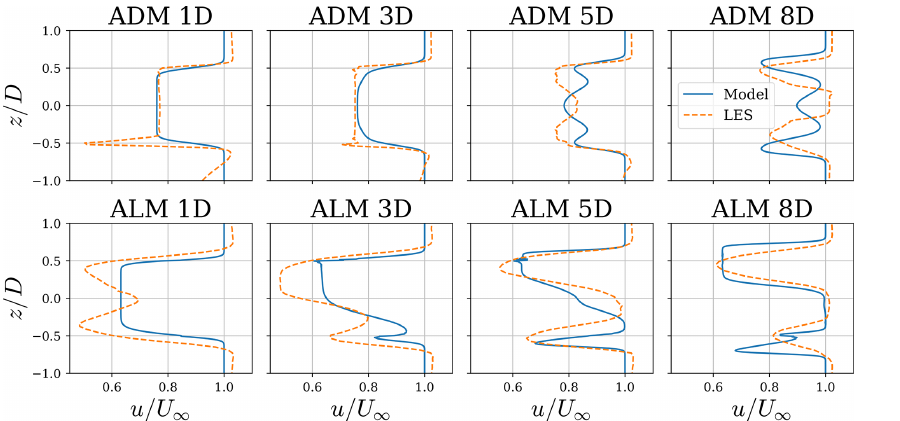
Figure 5. Comparison of axial velocity along a vertical line passing through the center of the rotor between a large-eddy simulation using an actuator disk model (a) and actuator line model (b) under uniform inflow from Howland et al. (2016) and the proposed